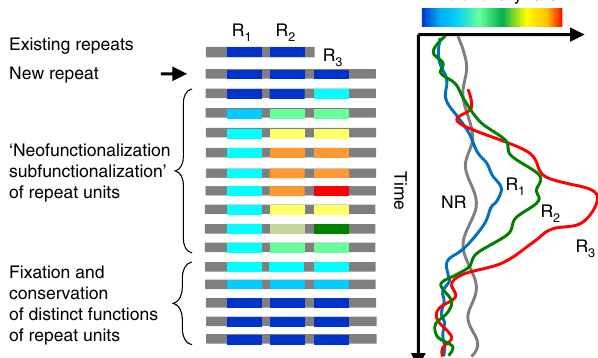
Figure 6 | A model of repeat evolution. Existing repeats (R1, R2) are functional and conserved. Once a new copy is generated (R3), evolution of all copies starts to accelerate. This acceleration is presumably more pronounced for the new copy, and those physically adjacent to it (see colour scale of the evolutionary rate). During this phase, the new copy (and possibly others) can acquire a new function (neofunctionalization) or become specialized towards improved execution of one of the existing functions (subfunctionalization). This phase is dominated by strongly relaxed purifying selection and positive selection, resulting in substantially increased evolutionary rates of R1, R2 and R3 (right panel). Once the new functions are fixed, evolution of the repeats slows down to rates characteristics, or even below, of the non-repetitive (NR) part of the protein (grey), and the repeats are maintained presumably due to strong purifying